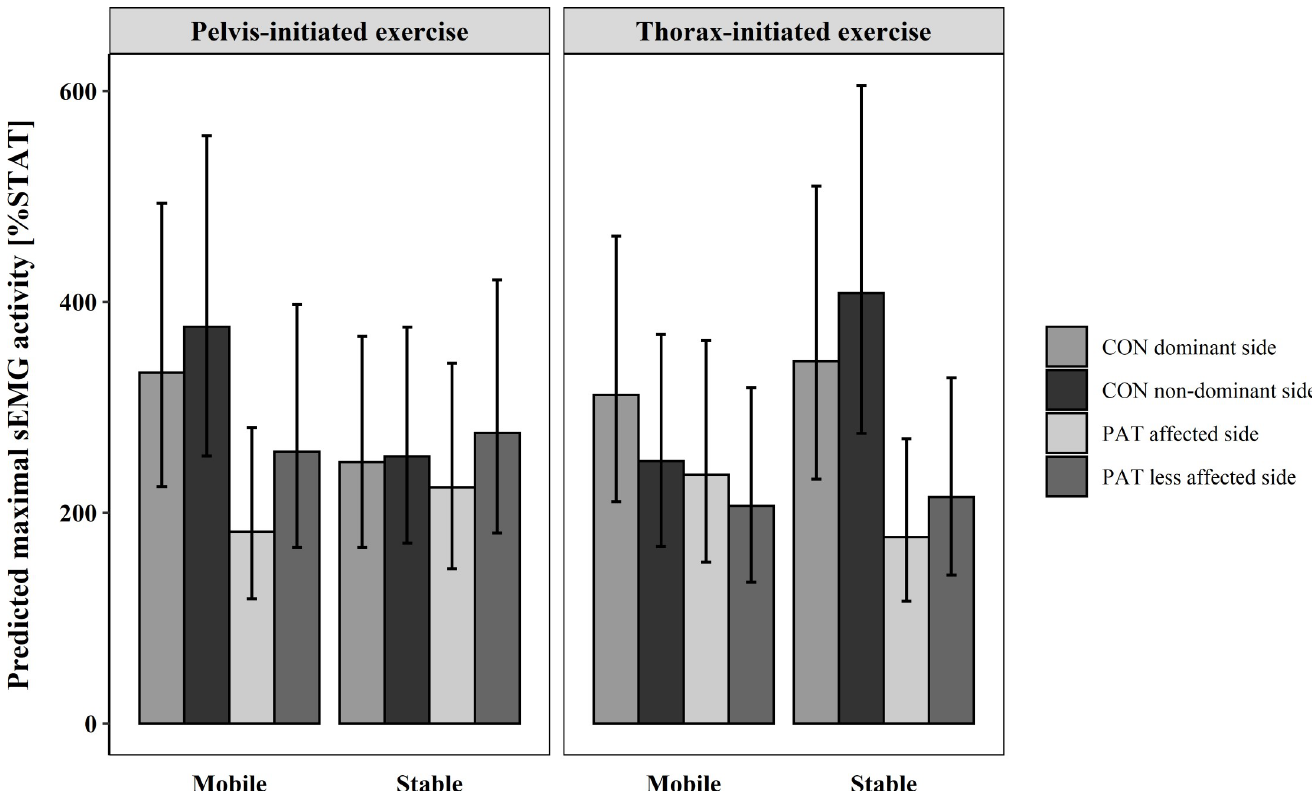
Fig 3. Predicted maximal sEMG activity and confidence level of each subgroup in M. multifidi. CON = healthy participants, PAT = people after stroke, % STAT = percentage of maximal muscle activity relative to static sitting on the stable seat.